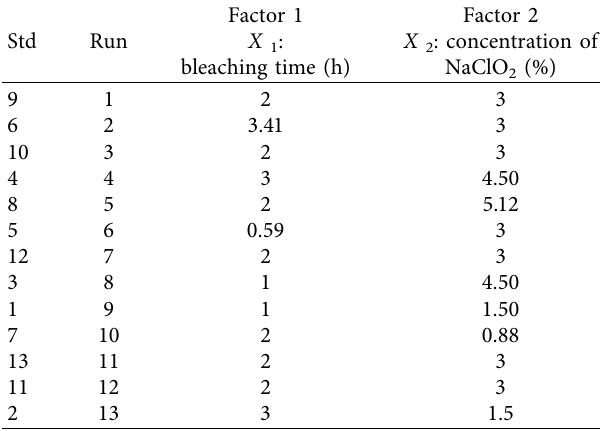
Table 2: Experimental design for optimizing cellulose isolation from